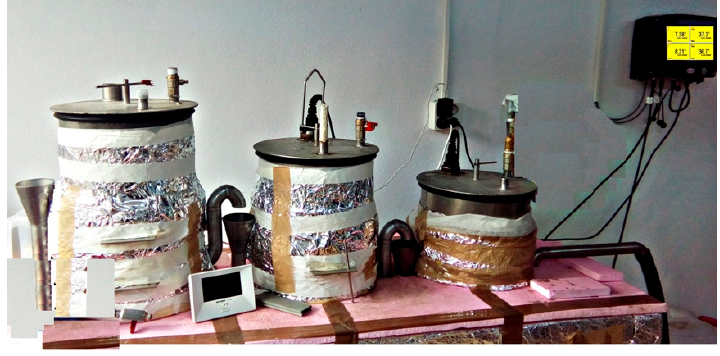
Figure 4. Experimental installation.